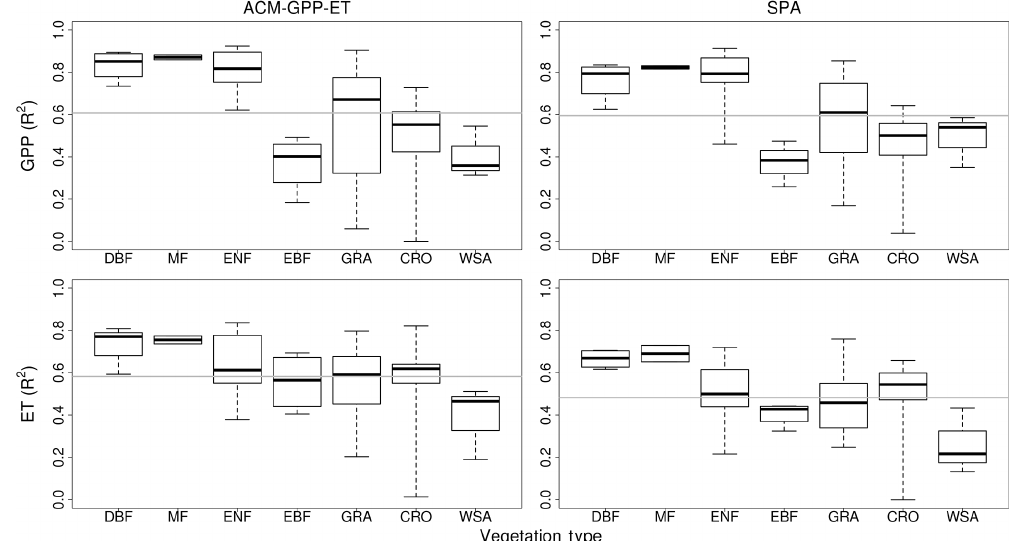
Figure 6. Independent validation of ACM-GPP-ET and SPA using eddy-covariance-derived estimates of gross primary productivity (GPP) and evapotranspiration (ET) from the FLUXNET2015 database. Box and whisker plots show the site-specific R 2 values for each of the International Geosphere-Biosphere Programme (IGBP) vegetation classification. CRO is cropland, CSH is closed canopy shrubland, DBF is deciduous broad-leaf forest, EBF is evergreen broad-leaf forest, ENF is evergreen needle-leaf, GRA is grassland, MF is mixed forest and WSA is woody savanna. The mean for each vegetation classification is shown by the thick centre line, and the box represents the 25% and 75% quantiles, while the whiskers indicate the minimum and maximum values. The horizontal grey line indicates the mean R 2 across